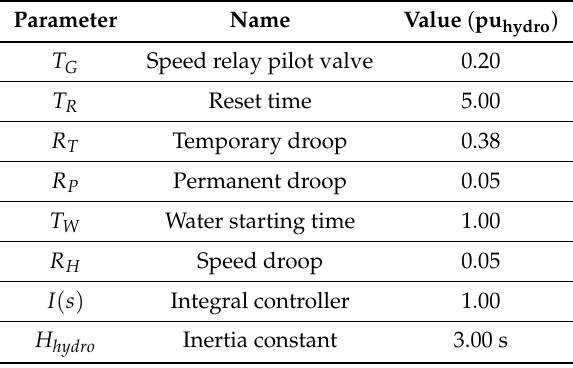
Table A2. Hydro-power plant parameters [26].